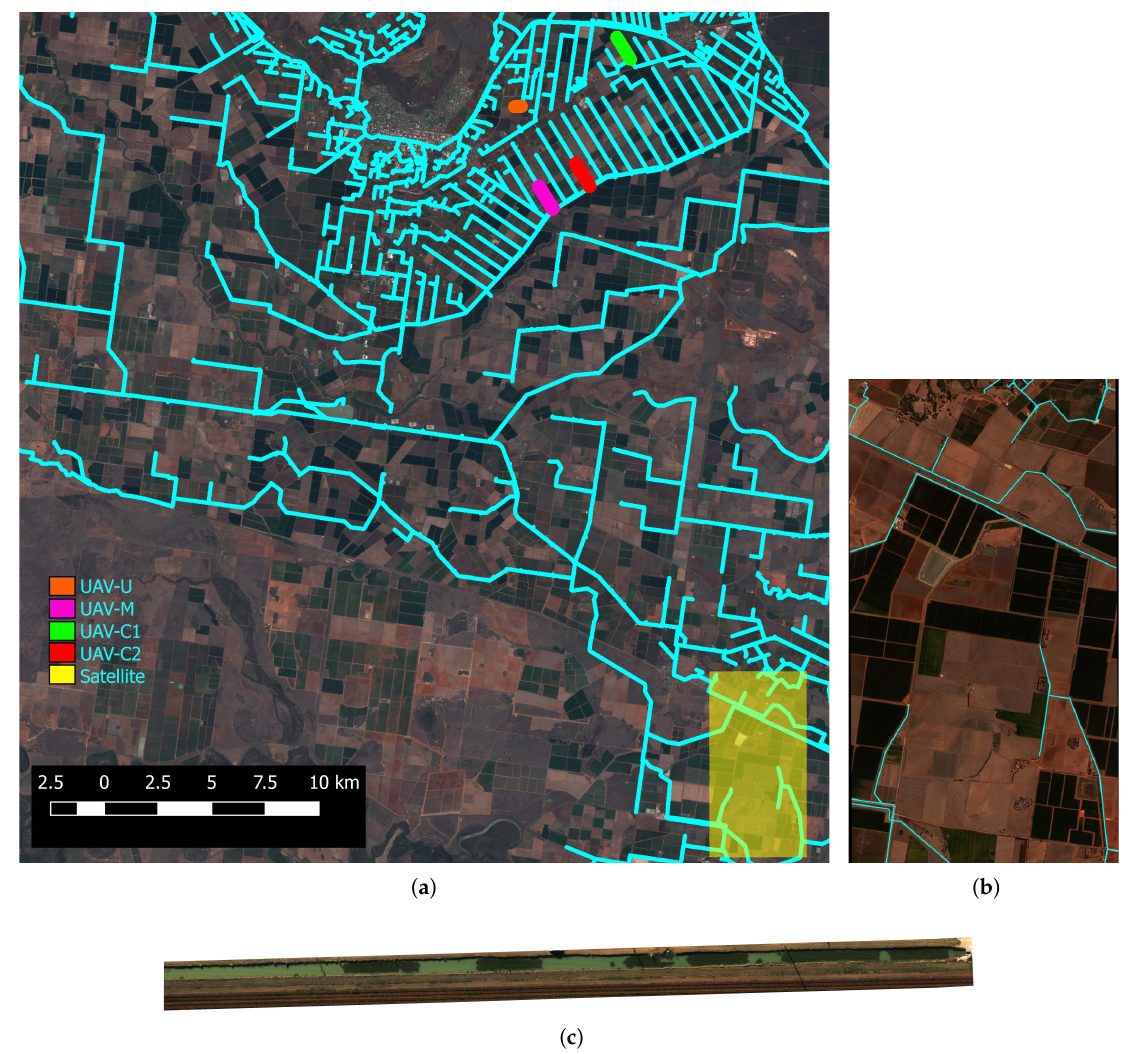
Figure 1. ( a ) a portion of the Murrumbidgee Irrigation Area with imagery from the Sentinel-2 constellation from 1 Jan 2018. The supply channels are shown in blue. The areas mapped by the UAV and satellite are shown; ( b ) one of the WorldView-3 satellite images; ( c ) UAV image of the untreated (U)